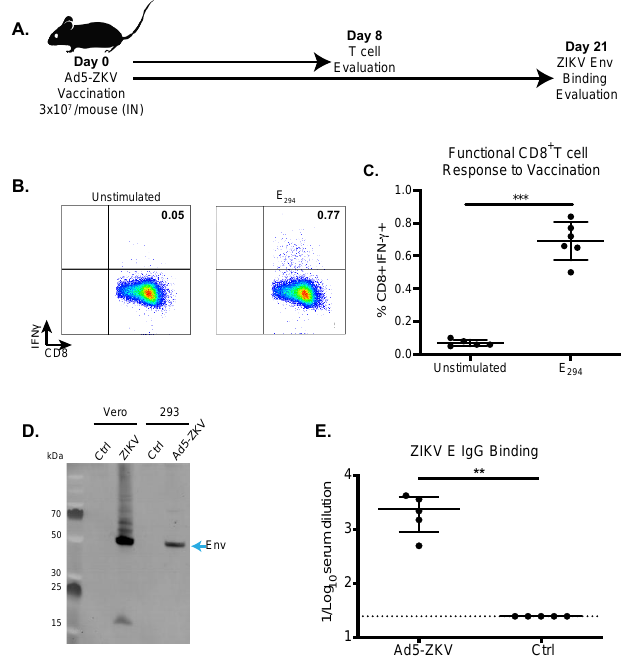
Figure 2. Immunogenicity of hAd5-ZKV vaccine in wild type C57BL / 6 mice. ( A ) Graphical timeline for hAd5-ZKV vaccination and the evaluation of immunogenicity. C57Bl / 6 mice were immunized with 3x10ˆ7 viral particles of hAd5 intranasally (i.n.), and antigen-specific CD8 + T cells responses and antibody binding were evaluated. Antigen-specific T cell responses from the spleen of vaccinated mice were evaluated at day 8 post vaccination. ( B ) Representative flow plot of the intracellular interferon gamma production of CD8 + T cells (gated on lymphocytes, CD8b + , and CD4 - / CD19 - ) after ZIKV E 294 peptide stimulation. ( C ) Percent of CD8 + T cells secreting IFN γ in response to antigen-specific peptide stimulation with n = 6 per group. Asterisks indicate statistical significance * ( p = 0.03), ** ( p = 0.002), *** ( p = 0.0002), and **** ( p < 0.0001) as determined by Mann–Whitney test. (D ) To determine the expression of ZIKV epitopes recognized after infection, ZIKV- and hAd5-ZKV-infected cells, and controls were evaluated by Western blot using ZIKV immune sera from C57Bl / 6 mice. ( E ) Humoral responses were evaluated in the sera of immunized mice at day 21 post vaccination by ZIKV E protein binding with an n = 5 per group. Data are the cumulative results of two independent experiments, and significance was determined by student’s 2-tailed t test * ( p = 0.03), ** ( p = 0.002), *** ( p = 0.0002), and **** ( p < 0.0001).